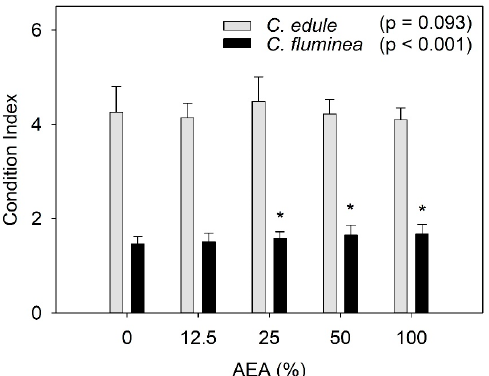
Figure 3. Condition index of Corbicula fluminea and Cerastoderma edule individuals after 96 h of exposure to aqueous extracts of ash (AEA) at different concentrations (0, 12.5, 25, 50, and 100%). Bars represent mean values and the error bars represent standard deviation. Asterisks stand for statistically significant differences relative to the control (0%) for each species.